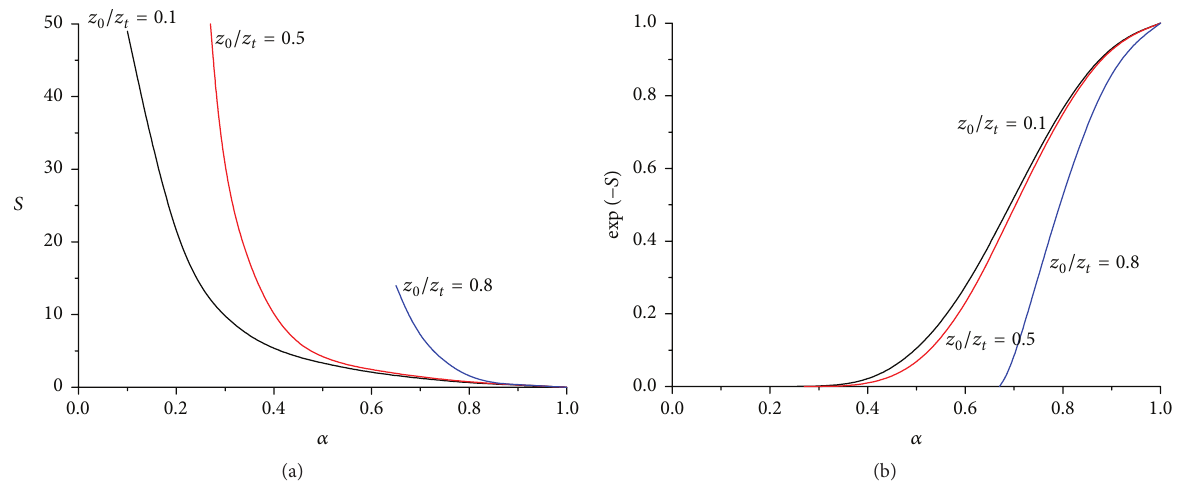
Figure 3: 𝑆 and 𝑒 −𝑆 versus 𝛼 with fixed 𝑄 = 0.2 . In all plots from left to right 𝑧 0 /𝑧 𝑡 = 0.1, 0.5, 0.8 .